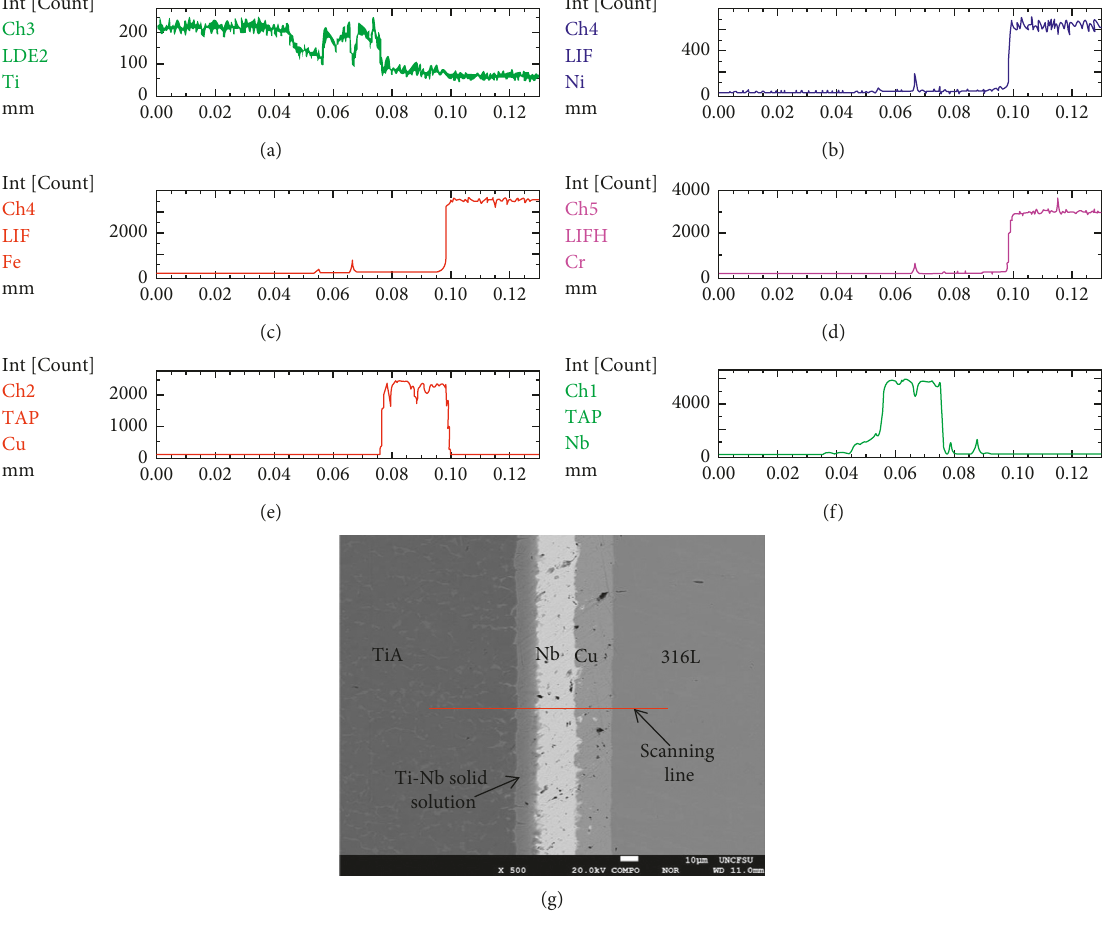
Figure 8: EPMA line scanning analysis of elements (a) Ti, (b) Fe, (c) Cu, (d) Ni, (e) Cr, and (f) Nb along with (g) a BSE image of a region at Ti-6Al-4V and 316L joint interface bonded at 900 °